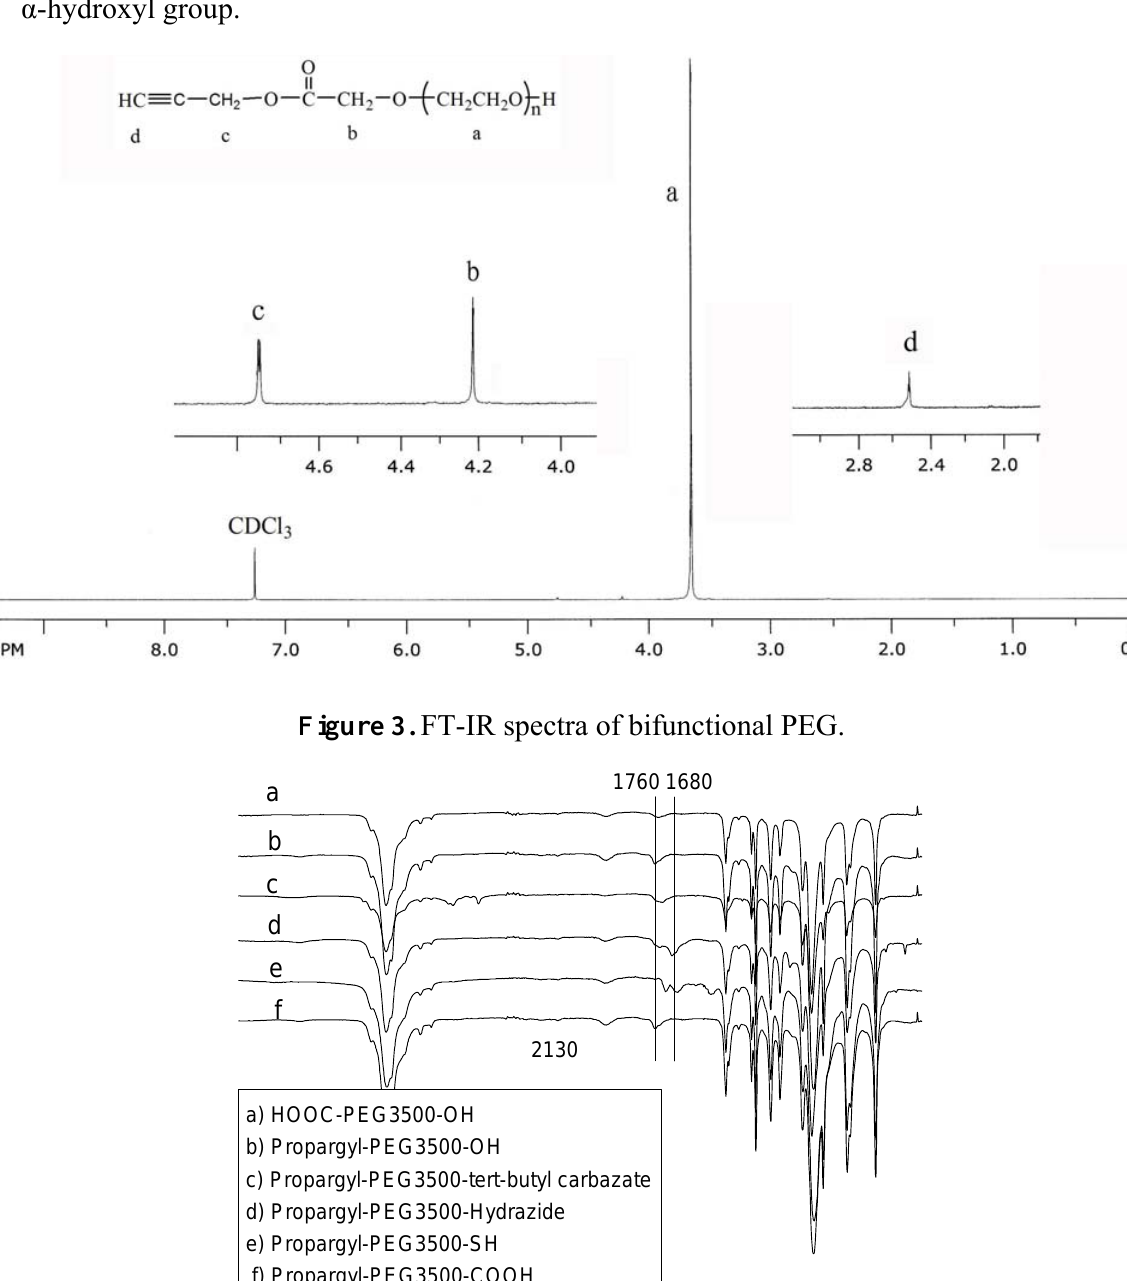
Figure 2. 1 H NMR spectrum of poly(ethylene glycol) with ω -propargyl group and α -hydroxyl group.